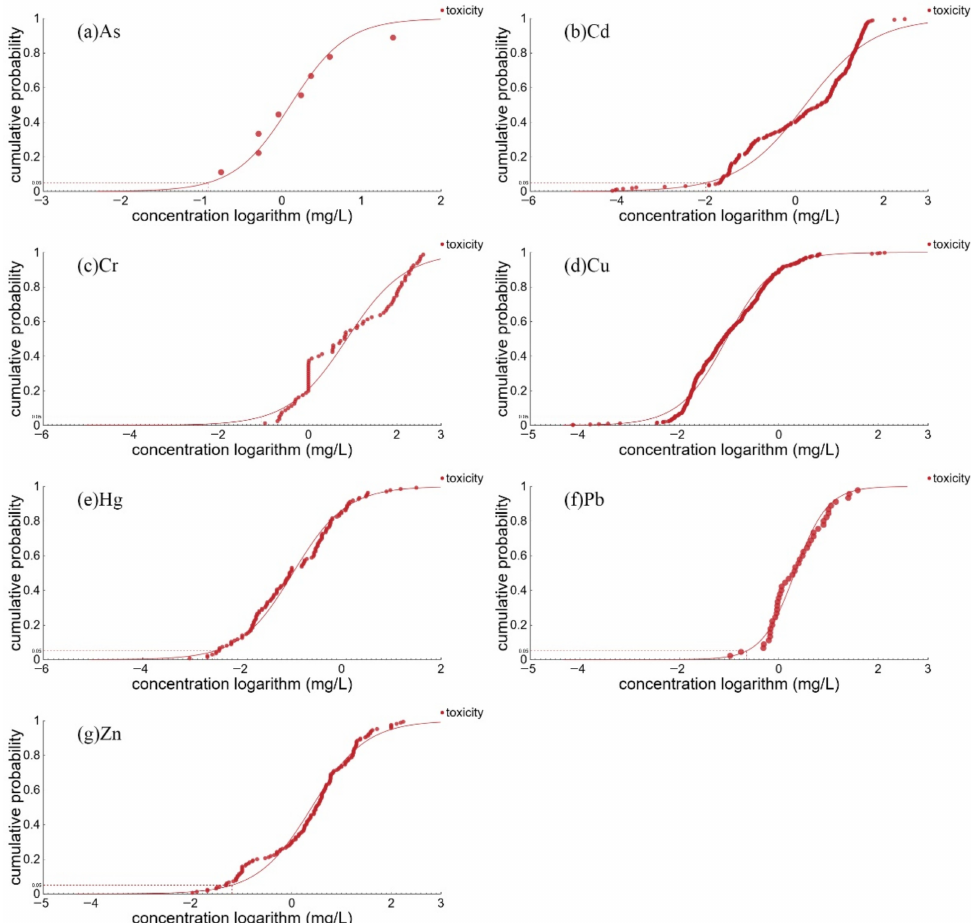
Figure 6. The species sensitivity distribution of heavy metals on coastal